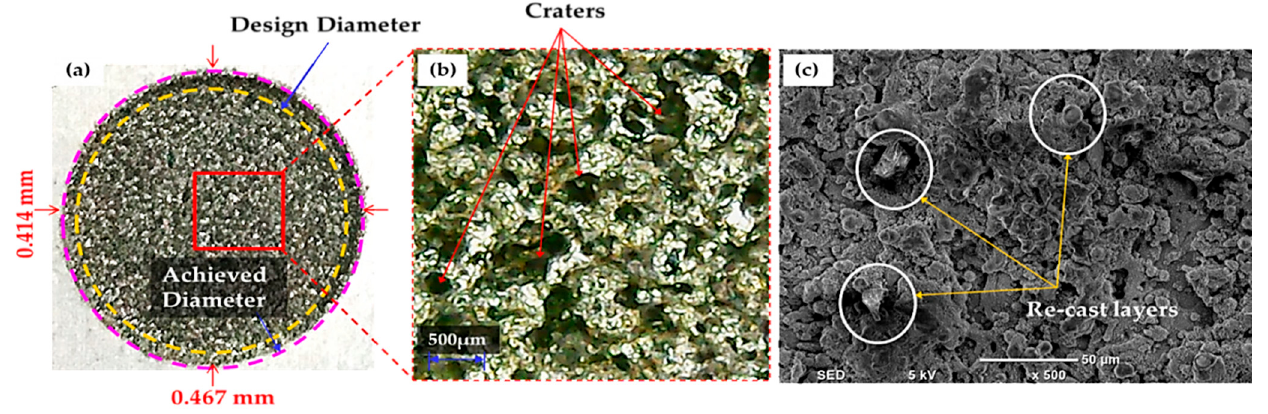
Figure 17. Experimental results obtained for the brass electrode: ( a ) actual machined surface showing a high value of overcut; ( b ) micrograph showing the presence of small size craters formed on the workpiece surface; ( c ) SEM micrograph showing the presence of deep craters on the surface of Ti-6Al-4V.